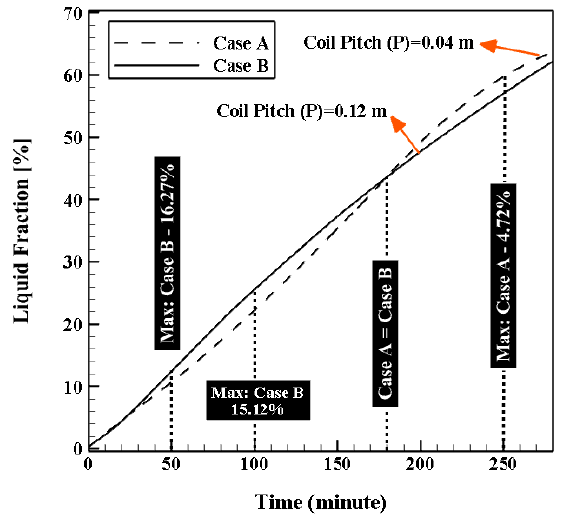
Figure 12. Temporal evolution of the liquid fraction (LF) for cases A and B.